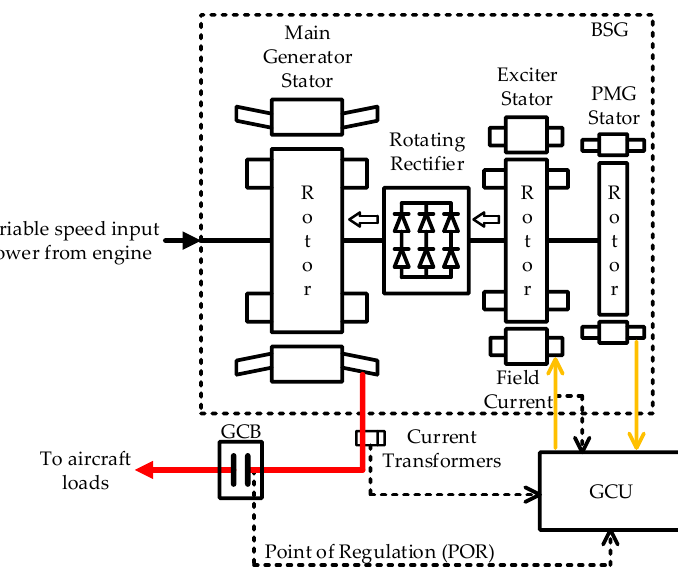
Figure 1. BSG system